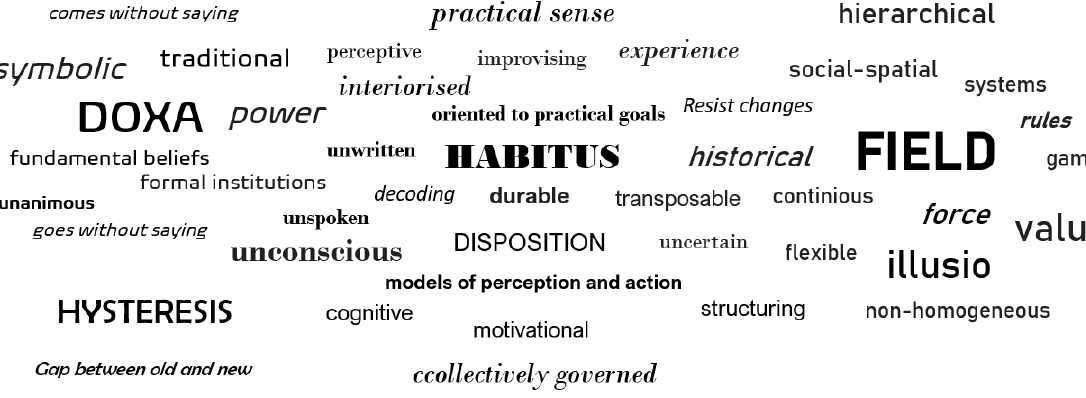
Figure 3. The components and attributes of habitus and